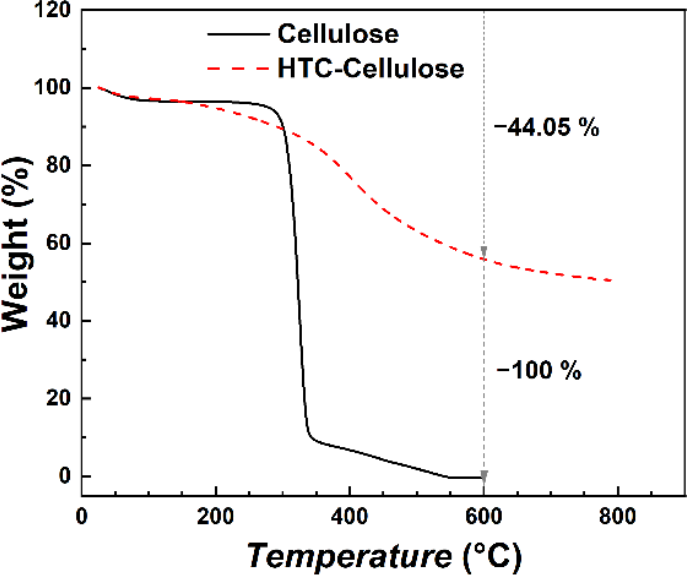
Figure 1. TGA analysis of the cellulose and HTC-Cellulose samples. Measurement ran in a nitrogen atmosphere.